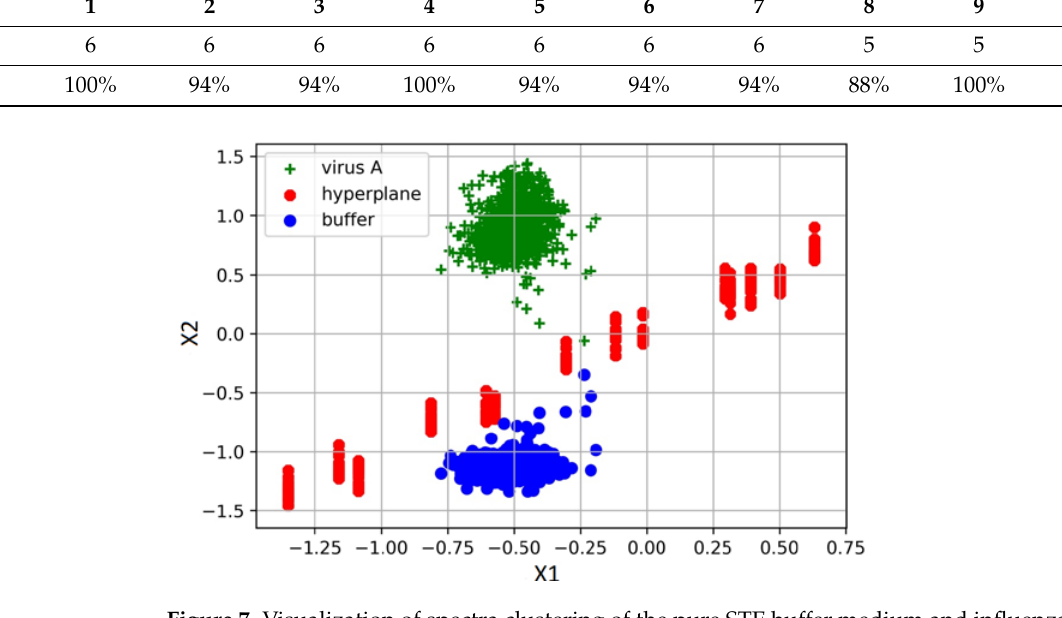
Figure 7. Visualization of spectra clustering of the pure STE buffer medium and influenza A virus in the STE buffer medium using projection onto support vectors X1 and X2. The red dots mark the projection of hyperplane points, which allows to classification of the spectra.